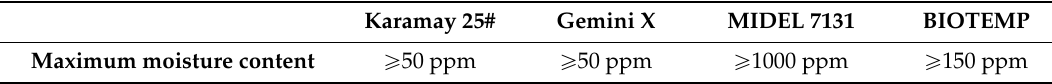
Table 2. The maximum moisture content in some kinds of insulating oils.